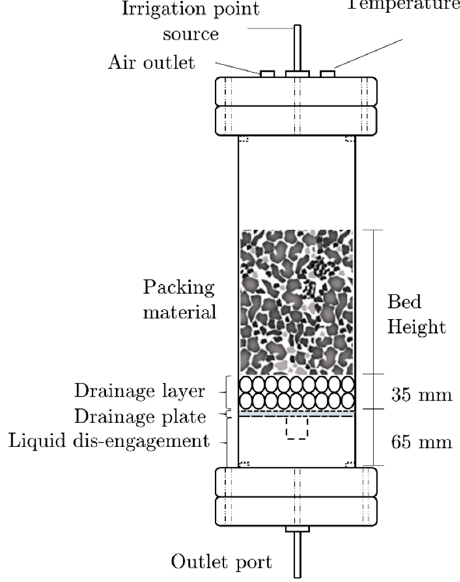
Figure 5. Illustration of the cylindrical column packing [29].